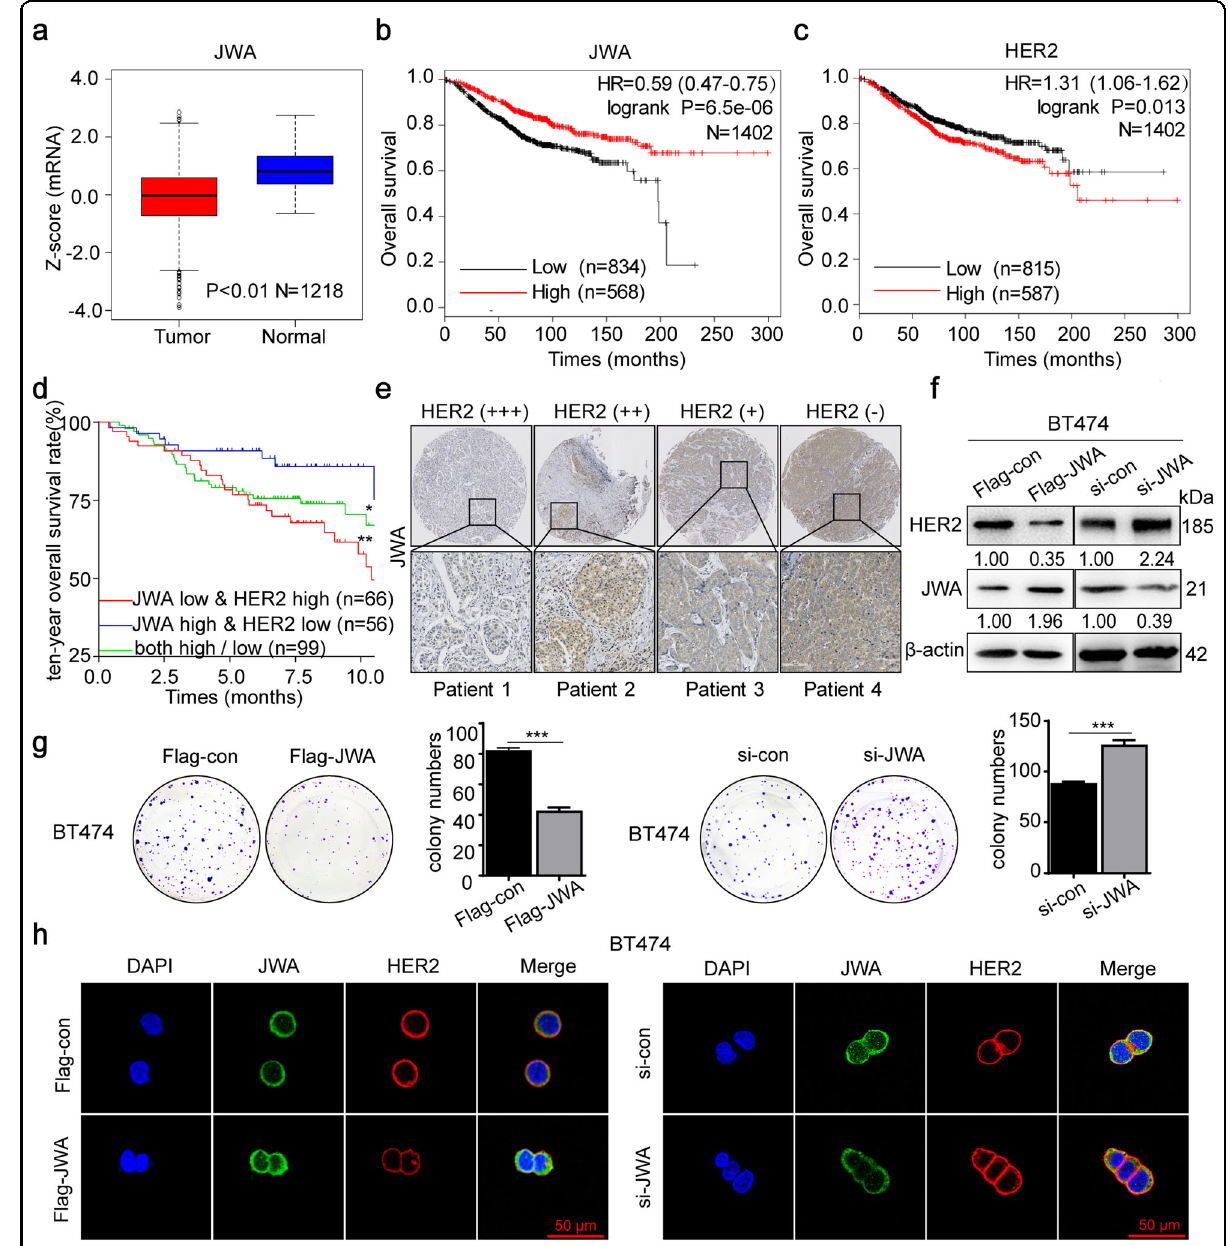
Fig. 1 JWA negatively regulates HER2 expression and cell proliferation in breast cancer. a The mRNA expressions of JWA in breast cancer tissues and adjacent non-cancerous tissues in unpaired cohorts (TCGA database, 1099 cancer samples, 119 non-cancerous samples). b , c Kaplan – Meier curves depicting OS according to the expression patterns of JWA ( b ) and HER2 ( c ) in the breast cancer cohort. P values were calculated with the log-rank test. d Kaplan – Meier OS analysis for breast cancer from GEO datasets (GSE88770 and GES42568). e Representative images of JWA IHC staining in breast cancer lesions with absent ( − ), weak ( + ), moderate ( ++ ), strong ( +++ ) expression of HER2 (original magni fi cation, ×2 and ×200). f Transfection of either Flag-JWA plasmid or si-JWA and their control into BT474 cells for 72 h, the expressions of HER2 and JWA proteins were determined by western blot. g Representative images of the colony formation assay for BT474 after transfection of Flag-JWA, si-JWA or their control. h Immuno fl uorescence imaging of JWA (green), HER2 (red), nucleus labeled as DAPI (blue), the co-localization of the three signals (merge) in BT474 cells transfected with si-JWA (right) or Flag-JWA for 72 h.